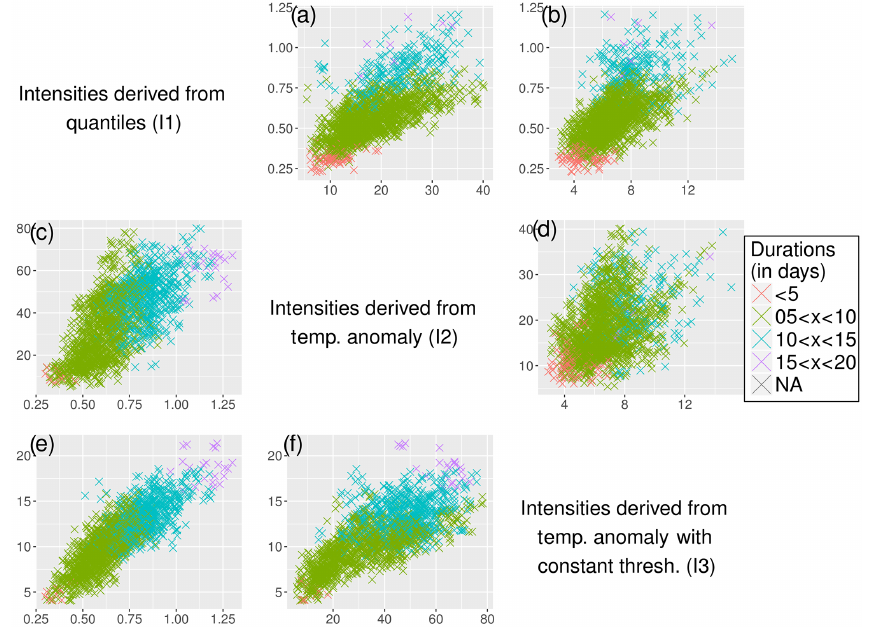
Figure 7. Matrix of scatter plots of the three intensity calculations related to quantiles, temperature anomalies and temperatures anomalies with constant thresholds (I1, I2 and I3 respectively) during heat (a, b, d) and cold (c, e, f) waves using LisFlood. The colours indicate the duration (in days) of each